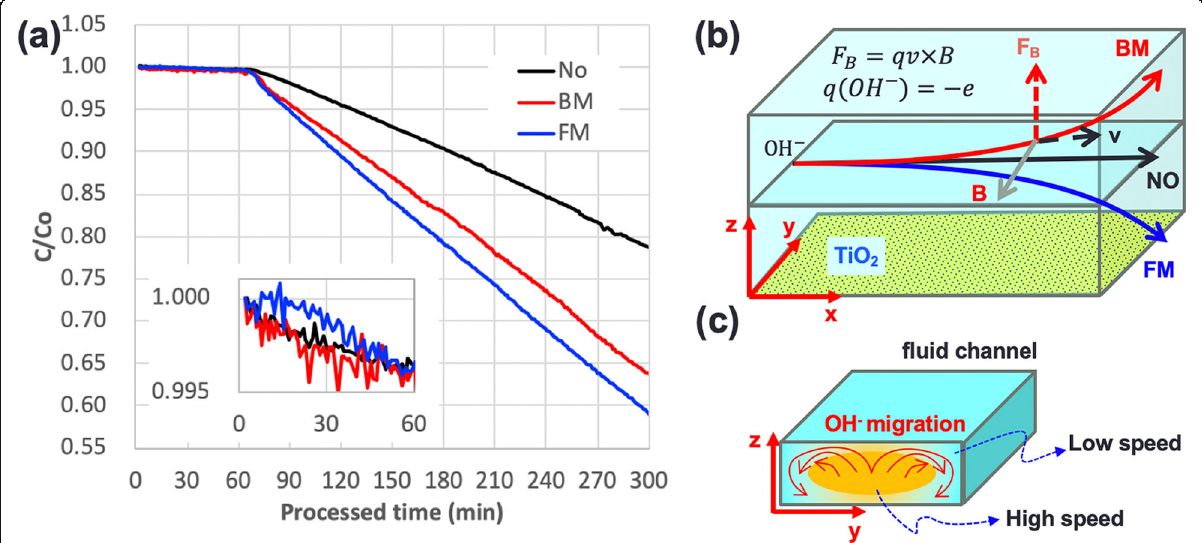
Fig. 5 Magnetic field effects on dark absorption and OH − migration. a Photocatalytic degradation of MO under the application of BM and FM. b Schematic of the magnetic field-induced migration of OH − in the micro optofluidic chip reactor. c Schematics of the OH − migration by